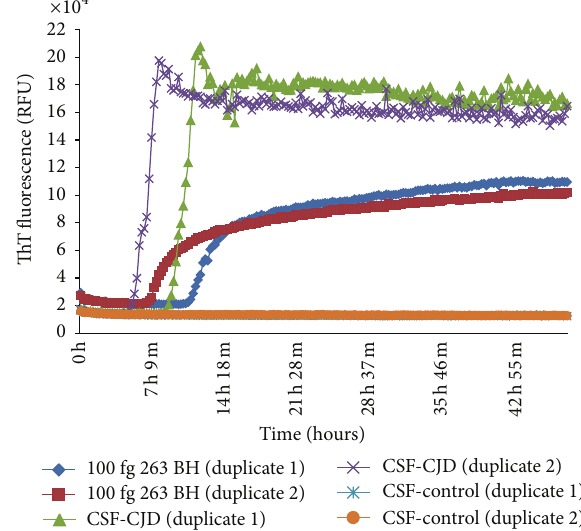
Figure 1: RT-QuIC reactions seeded with 15 𝜇 L of human CSF samples from one Italian sporadic CJD patient (12076) and one non-CJD control (13004). 100fg of 263K prion-infected hamster brain homogenate were used to seed positive control reactions. Each sample was processed in